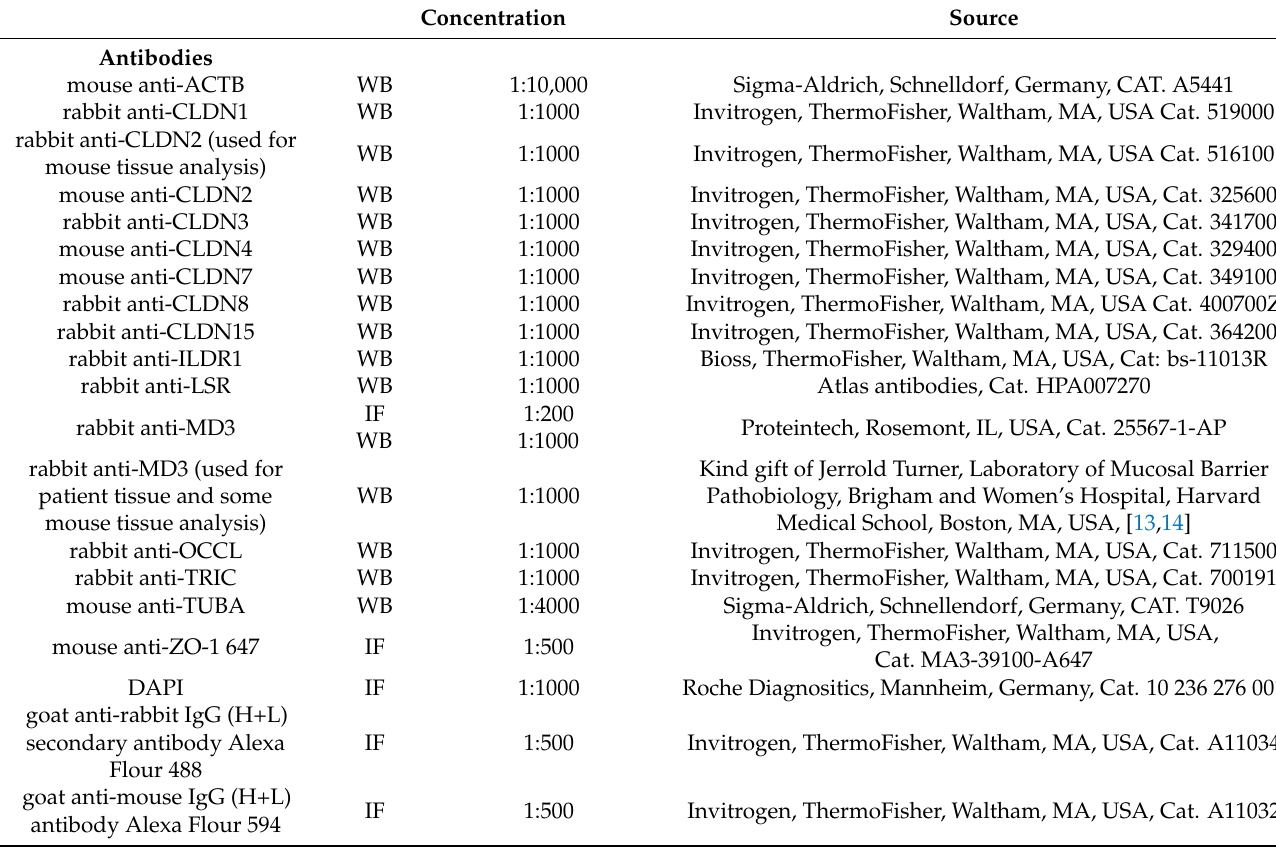
Table 2. Cytokines, inhibitors, and antibodies used in this study.